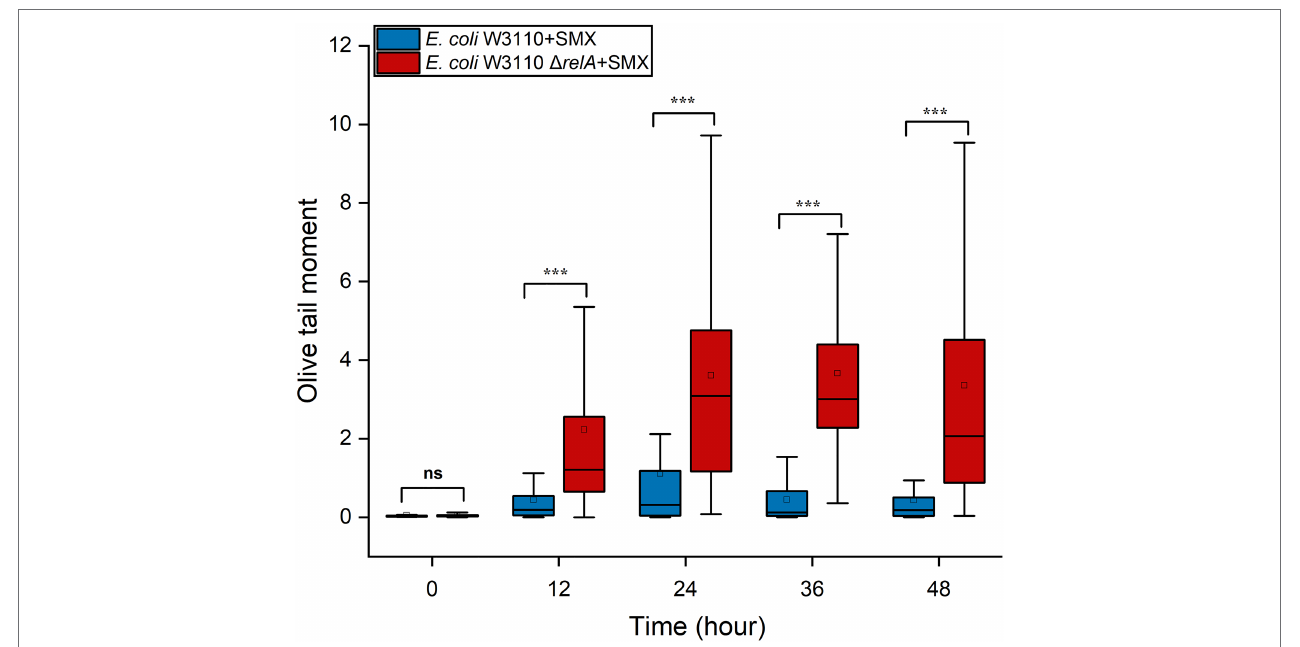
FIGURE 5 | SMX treatment induces extensive DNA DSBs in the Δ relA mutant. Box-plot of Olive tail moment levels of DNA from wild-type E. coli and the Δ relA mutant treated with SMX (10 μ g/ml). The horizontal line inside the box indicates the median of 80 cells, and the average is shown by the small square above the median line. Asterisks indicate statistically significant differences between means as determined by unpaired two-tailed Student’s t test (* p ≤ 0.05, ** p ≤ 0.01, *** p ≤ 0.001; ns, not significant p >